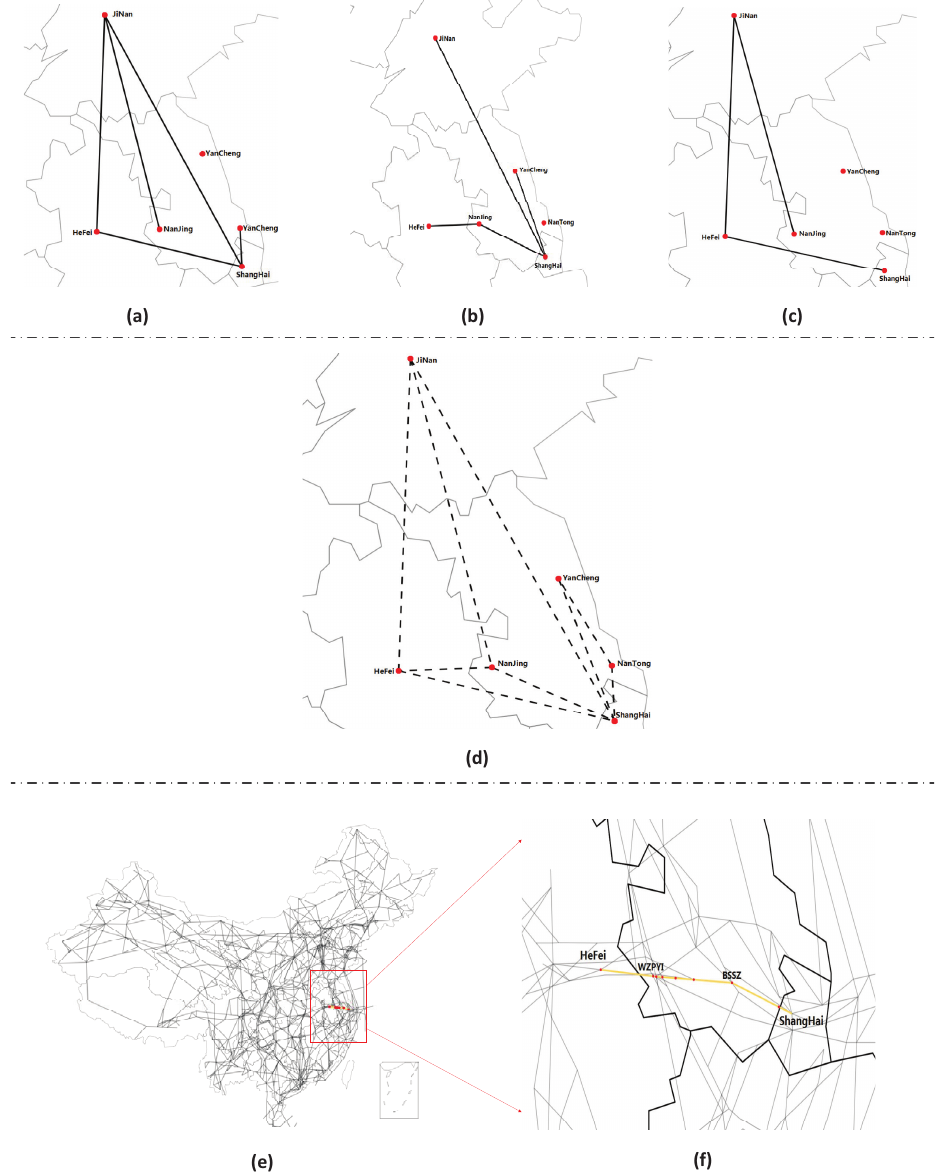
Figure 3. An example of the mapping relations of a three-layer air transport network with six cities, JiNan, HeFei, YanCheng, NanTong, NanJing, and ShangHai. ( a – c ) show the flight operation networks in the time intervals of 9:00–10:00, 18:00–19:00, and 21:00–22:00, respectively. ( d ) shows the city-pair airline network among these six cities. ( e ) shows the air route network of China, and ( f ) shows the routing path on the air route network for the city-pair airline “Hefei → Shanghai